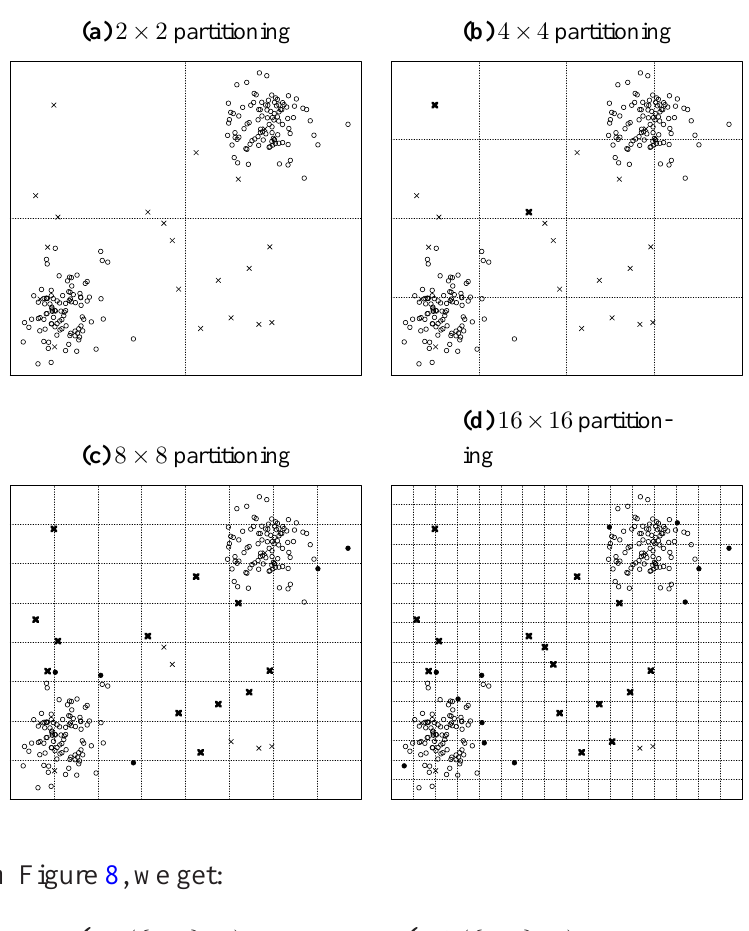
Figure 7. Recursively and uniformly partitioning on attribute subset